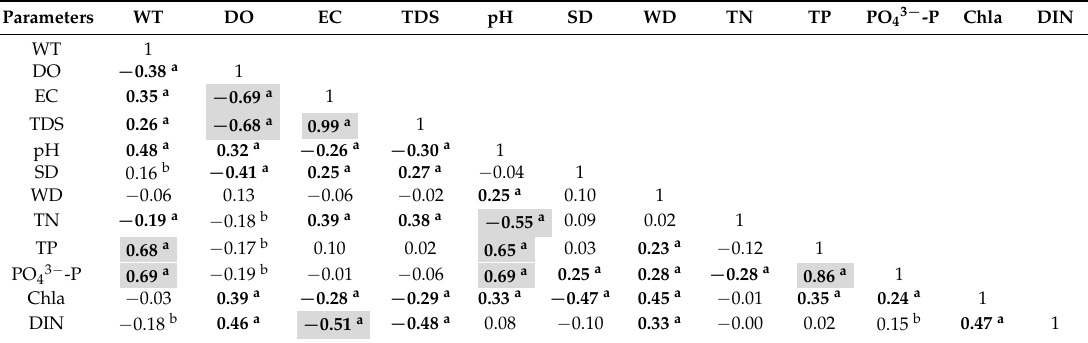
Table 3. Correlation analysis of water quality parameters (Spearman correlation